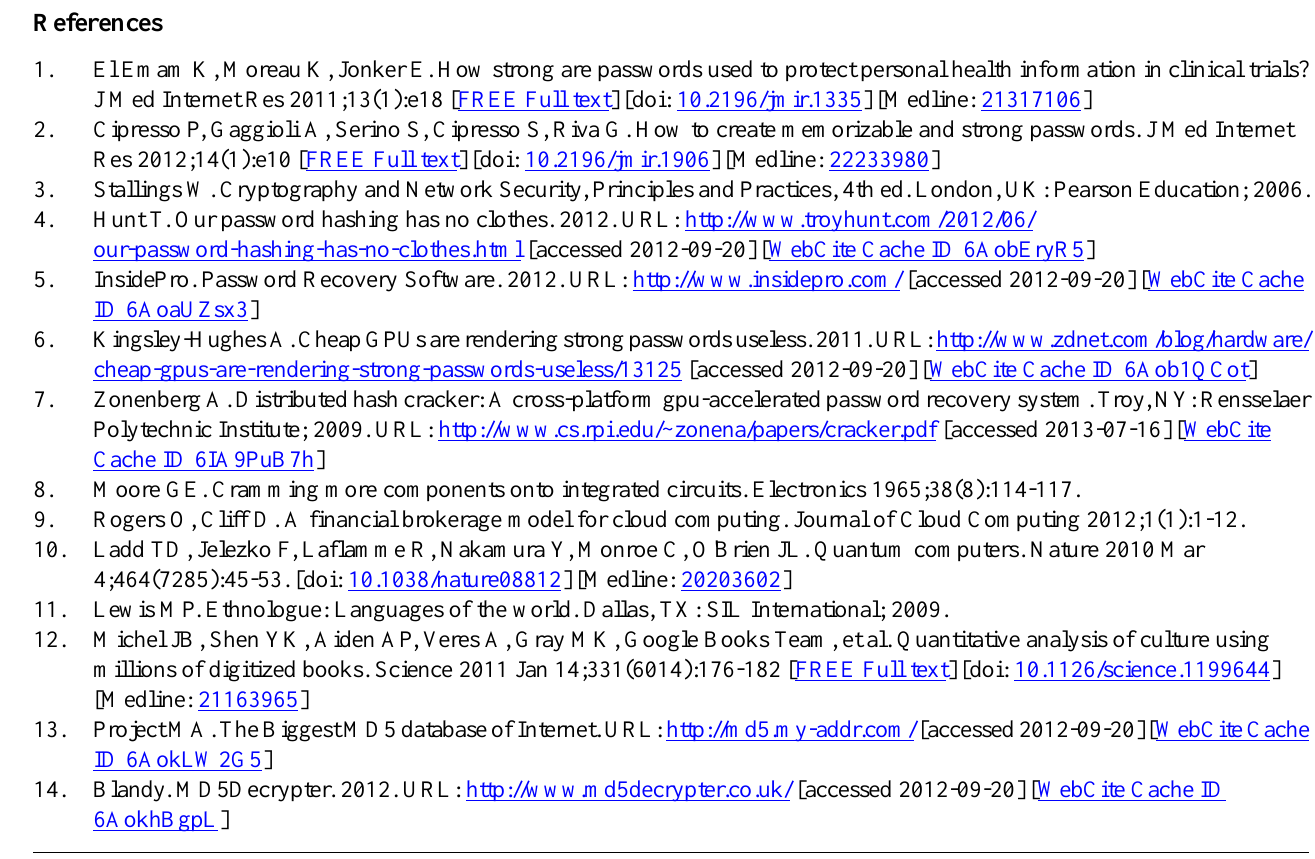
AZERTY: specific keyboard layout for the characters of the Latin alphabet that takes its name from the first 6 letters to appear on the first row of alphabetical keys. It is mostly used in France and Belgium. GPU: graphics processing unit ICS: Ice Cream Sandwich (Android Version 4.0) QWERTY: keyboard layout that is mostly used in United Kingdom, United States of America, Canada (and other countries) and is named after the first 6 letters in the first letter row on some